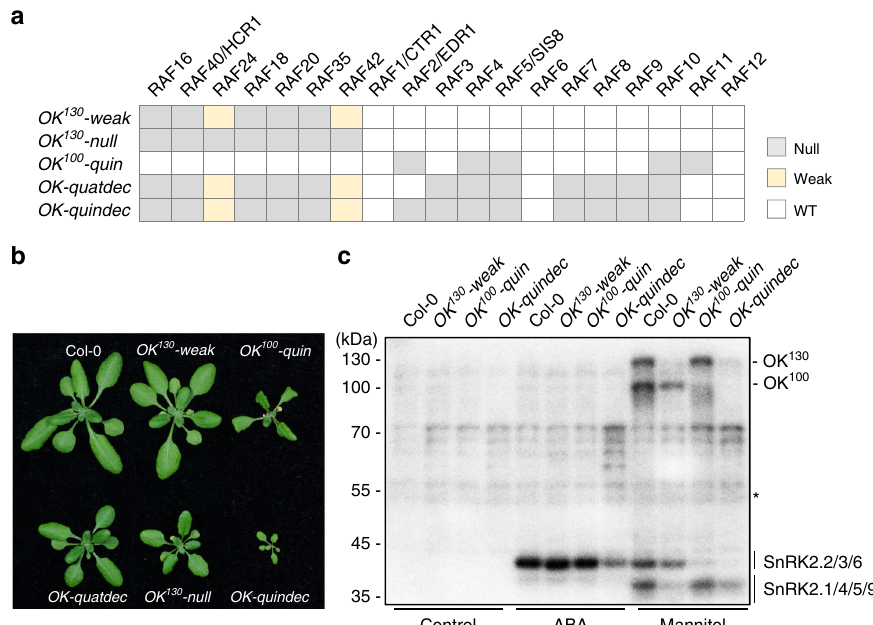
Fig. 3 Genetic identi fi cation of OKs as subgroups of Raf-like protein kinases. a Mutations of RAF genes in high-order mutants used in this study. Wild type (WT), knock-out mutant (null), or weak alleles (weak) are indicated with different colors. b Photographs of seedlings after 4 weeks of growth in the soil. c In-gel kinase assay showing the SnRK2 and OK activities after 15 min of ABA or mannitol treatments in wild-type and OK 130 - weak, OK 100 -quin , and OK-quindec mutants. Images shown are representative of two independent experiments. Source data are provided as Source Data fi